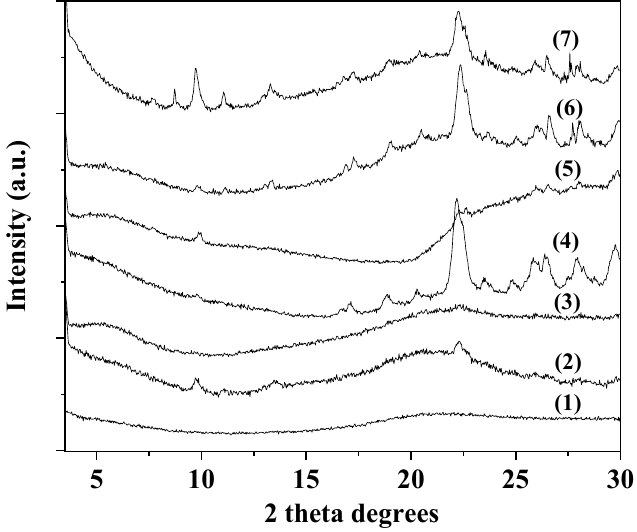
to Heulandite Ca(Si 7 Al 2 )O 16 × 6H 2 O monoclinic crystal phase (PDF-41-1357). This means